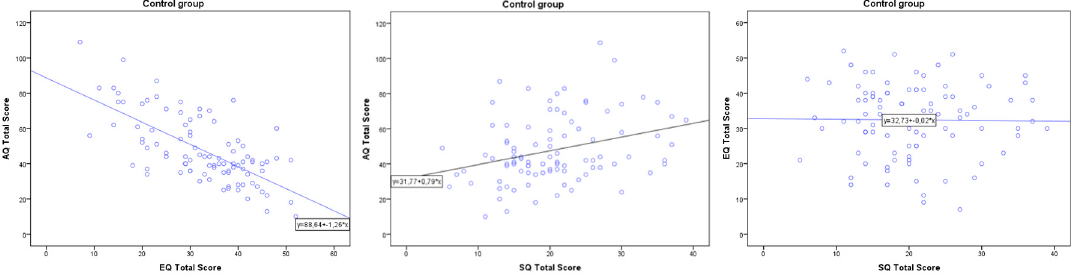
Figure 2. Strong negative relationship between the AQ Child_NL and EQ Child_NL in the typical group; strong positive relationship between the AQ Child_NL and the SQ Child_NL in the autism group.